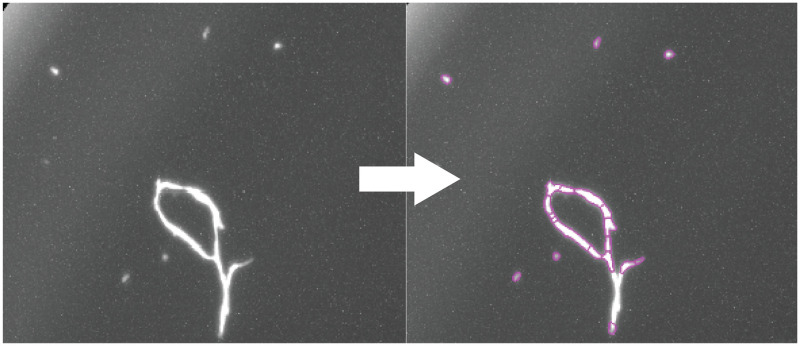
Debris in unfiltered medium interferes with cell counts.Unfiltered DMEM (supplemented with 10% FBS) contains particulates that the imaging software will incorrectly identify as cells (purple outlines).